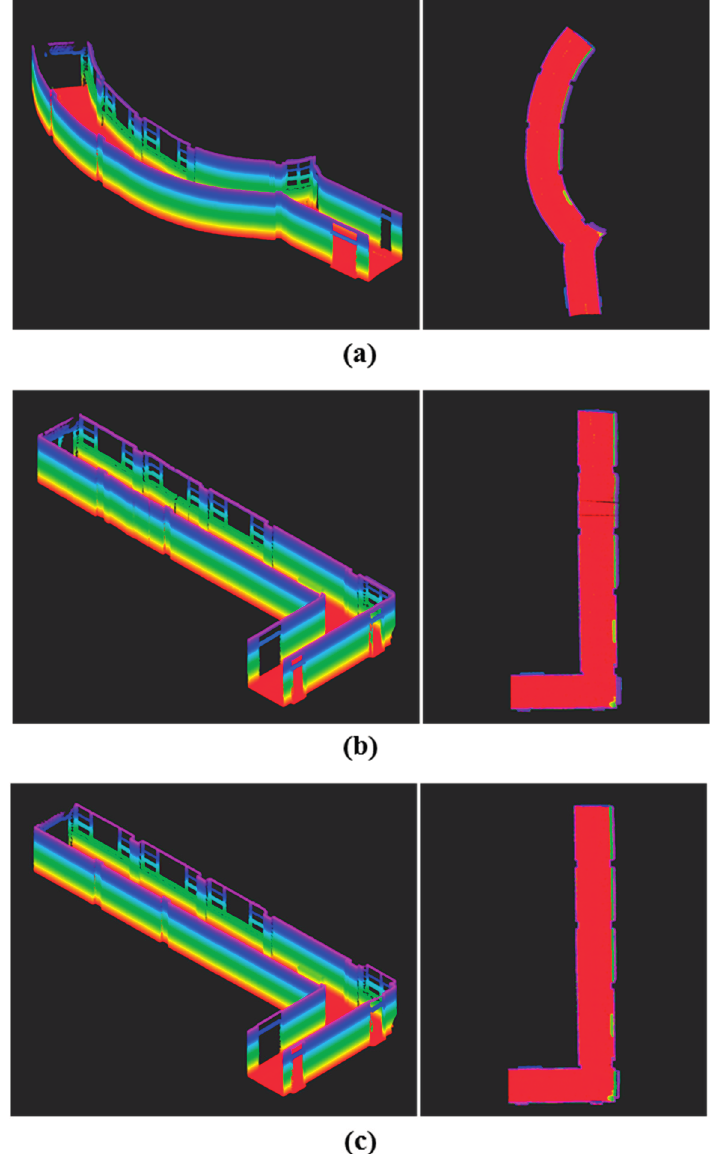
Figure 15. Point-cloud data acquisitions of the corridor by kinematic scanning: ( a ) odometry only; UKF SLAM ( b ) without and ( c ) with the constraint